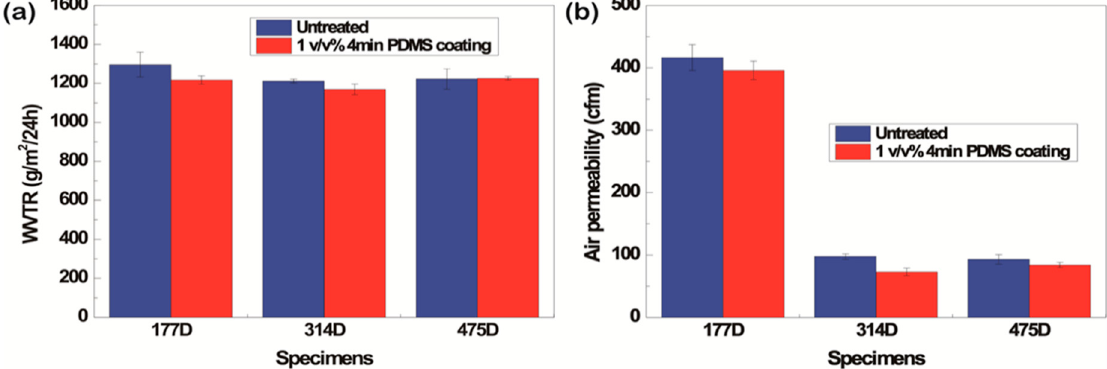
Figure 15. Water vapor transmission rate ( a ) and air permeability ( b ) before and after P1T4 PDMS coating.